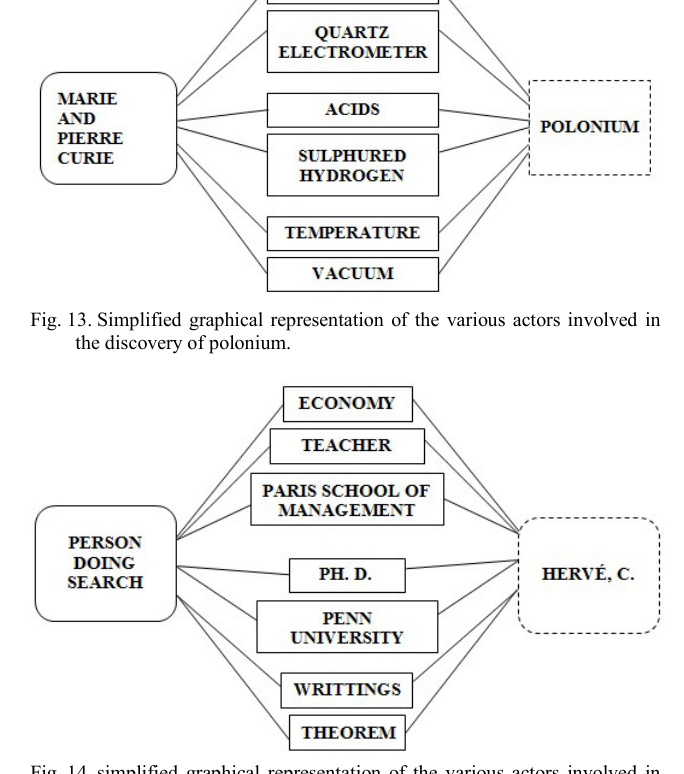
Fig. 14. simplified graphical representation of the various actors involved in the identification of a person based on the information published by him in an online